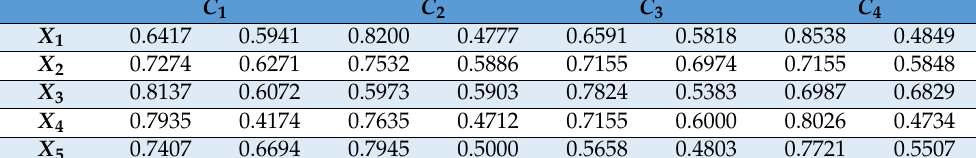
Table 8. Collective preferences using q-ROFAAA of expert’s information given in Tables 5–7. C 1